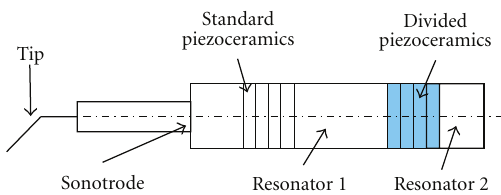
Figure 14: Layout of the redesigned structure with two piezostacks.